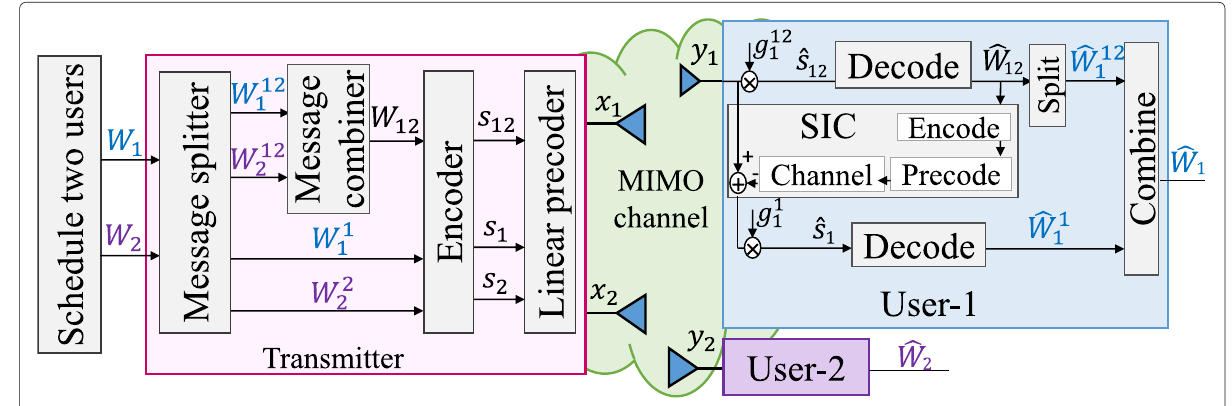
Fig. 1 Two-user transmission model using